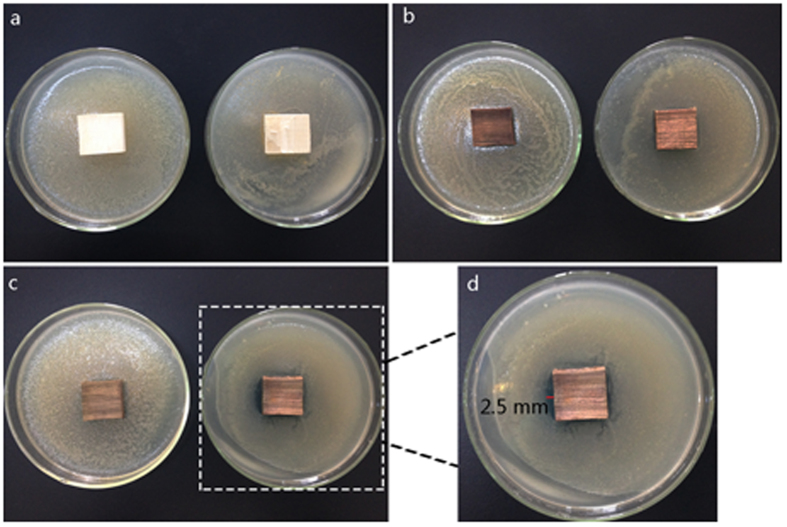
Antibacterial activity of (a) the TiO2-treated wood, (b) the Cu2O-treated wood and (c) the hydrophobized TiO2/Cu2O-treated wood in Staphylococcus aureus and Escherichia coli, respectively, and (d) the magnified picture of the hydrophobized Ag/TiO2–coated wood in Escherichia coli.